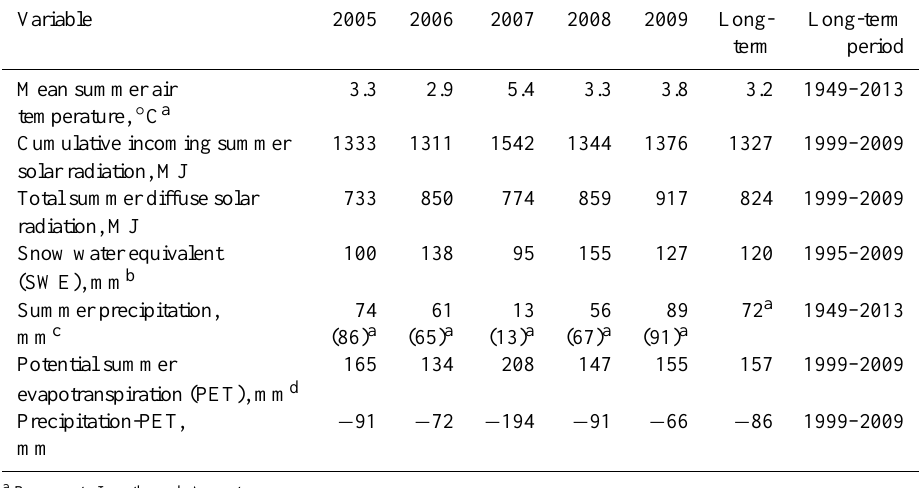
Table 1. Meteorological and hydrological conditions at the Barrow Environmental Observatory, Alaska, for the indicated periods in 2005– 2009 compared to long-term means. Summer 2007 experienced the lowest precipitation over the period 1949–2009 (followed by 1991, 19mm) and was the fifth warmest summer. Values represent end-of-snowmelt to the end of August unless otherwise stated. Precipitation values in parentheses 2005–2009 represent the total for June through